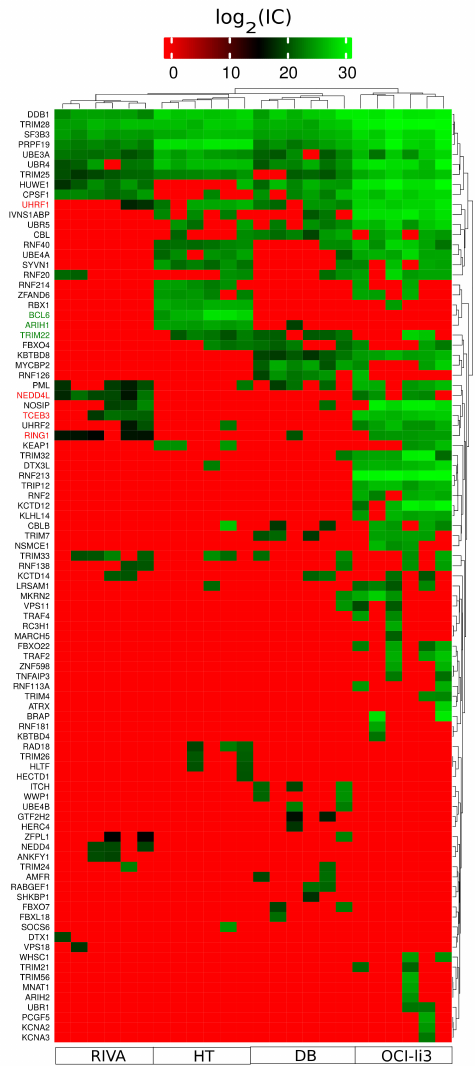
Figure A7. Log 2 ion counts for E3 ligases complex components. Protein names in green indicate E3 ligases upregulated in GCB and in red upregulated in